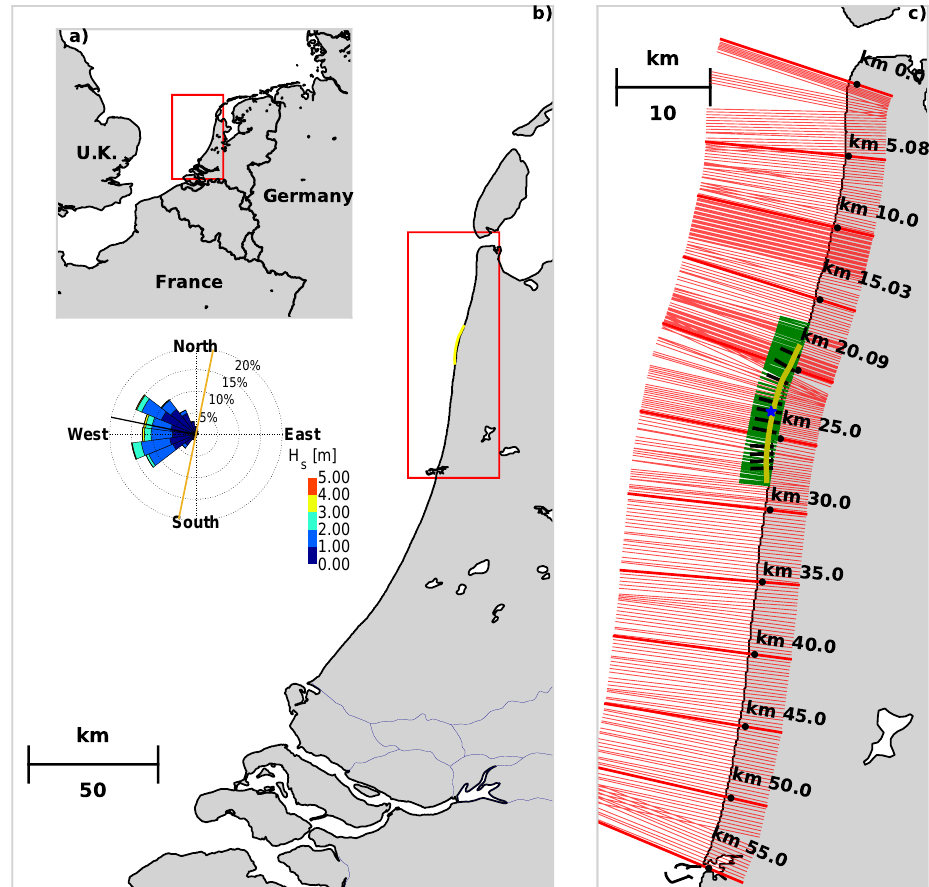
Figure 2. Location of case study site and an overview of the survey transects from available datasets. ( a ) Location of Dutch coastline within Europe. ( b ) Location of Hondsbossche Dunes nourishment (yellow line) at the Dutch coast including local nearshore wave climate at HD at − 10 m + NAP depth based on a 20-year hindcast time-series derived by Kroon et al. [36]. ( c ) Location of transects from Jarkus (red), contractor survey transects (green), and 11 constructor high-temporal-resolution transects (black); the blue star indicates the location of the nearshore wave